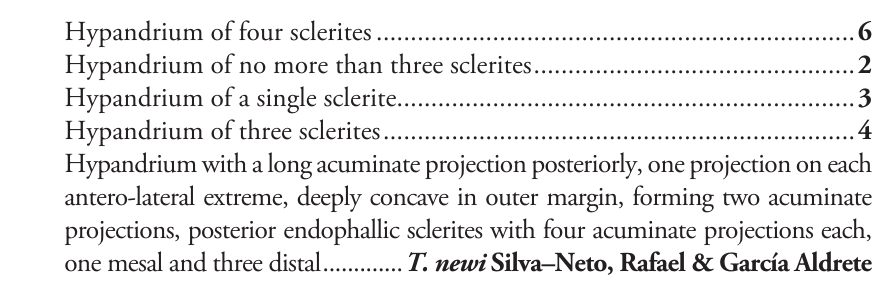
Male. Color. Body yellow, with ochre spots as indicated below. Compound eyes black, ocelli hyaline, with ochre centripetal crescents. Head pattern (Fig. 27). Scape brown, pedicel pale brown, f anteriorly pale brown, posteriorly yellow, apex white, f 1 2 yellow. Mx4 brown. Tergal lobes of meso and methathorax pale brown, pleura yellow; femora pale yellow, tibiae pale brown, tarsomeres 1–3 yellow. Forewing with an irregular, submarginal pale brown band from R to posterior end of areola postica, this with a 2+3 small brown spot proximally, and a dark brown spot between its apex and M; a triangular brown area next to CuA, and a brown spot at confluence of CuP–1A; pterostigma with brown bands anteriorly and posteriorly; veins brown, with brown spots at wing margin (Fig. 28). Hindwing almost hyaline, with small brown spots distally on veins M, R and 2+3 R with a pale brown spot at confluence of CuP and wing margin; veins brown (Fig. 29). 4+5; Morphology. As in diagnosis, plus the following: compound eyes without interom- matidial setae. Outer cusp of lacinial tip broad, with five denticles (Fig. 30). Forewing pterostigma wider in the middle, narrow anteriorly; Rs convex, R almost straight proxi- 2+3 mally and concave distally, R sinuous, M stem slightly concave proximally, then almost 4+5 straight, M –M sinuos, areola postica wide basally, slightly slanted posteriorly; hindwing 2 3 Rs almost straight, R and R straight, M sinuous. Hypandrium of three sclerites; side 2+3 4+5 sclerites, large, irregular, with setae as illustrated (Fig. 31). Phallosome with side struts independent, V shaped, fused posteriorly to external parameres, these stout, with pores posteriorly. Anterior pair of endophallic sclerites elongate, sinuous, distally acuminate; a central pair, narrow, elongate, sinuous, heavily sclerotized, with anterior end blunt, pos- teriorly dilated, lance-shaped; a lateral pair biramous, with inner arms long, curved out, wide based, extended posteriorly and distally acuminate, and outer arms wider in the mid- dle, narrowing at the ends, posteriorly shaped like a bird’s head; posterior pair, small, cur- ved outwards, distally acuminate (Fig. 32). Paraprocts broad, almost triangular, sensory fields with 20–31 trichobothria on basal rosettes, setae as illustrated (Fig. 33). Epiproct trapeziform, wide anteriorly, with sides converging towards a straight posterior border, three mesal setae near anterior border, other setae as illustrated (Fig. 33).